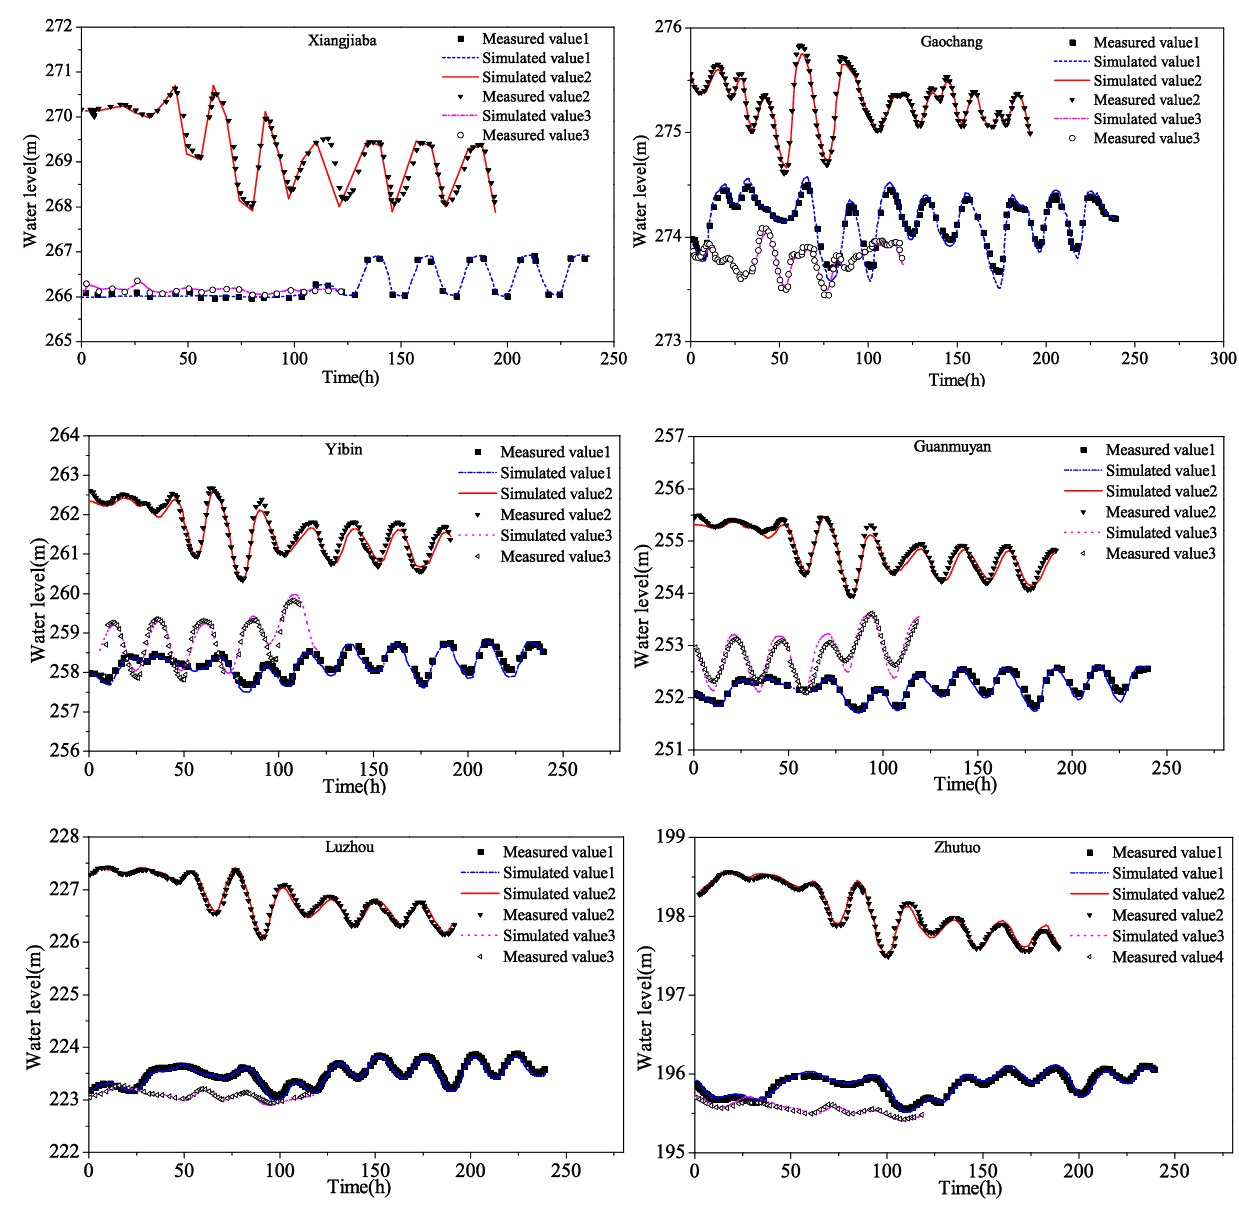
Fig. 13 Unsteady flow verification